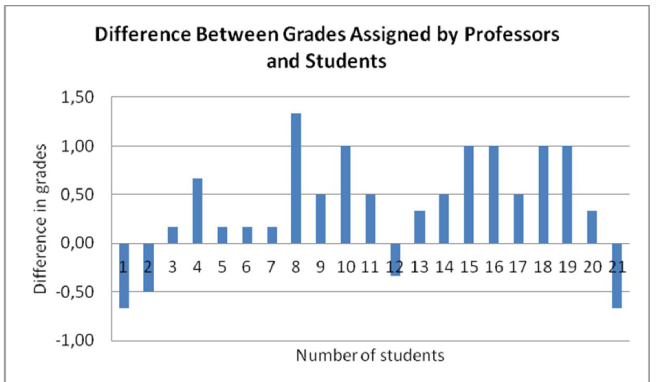
Figure 1. Diference between the grades given by the course professors and the average